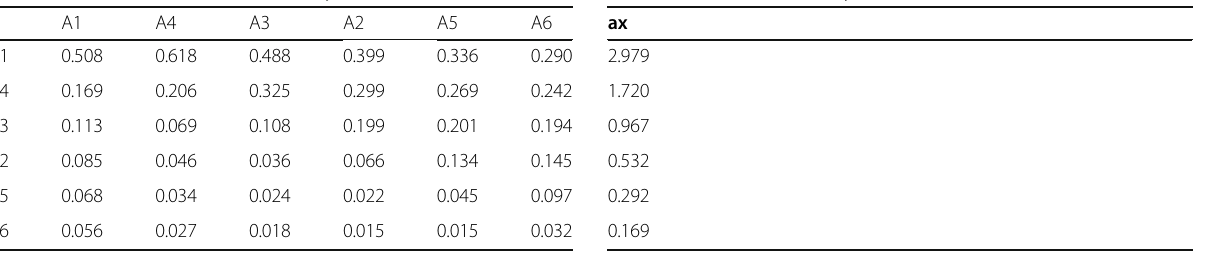
Table 2 Normalized column summary